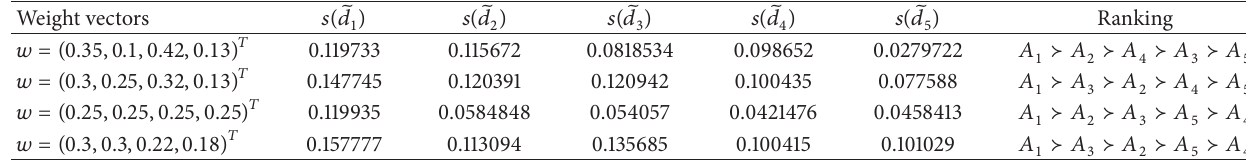
Table 3: Scores for theses obtained by DHFOWA operator.